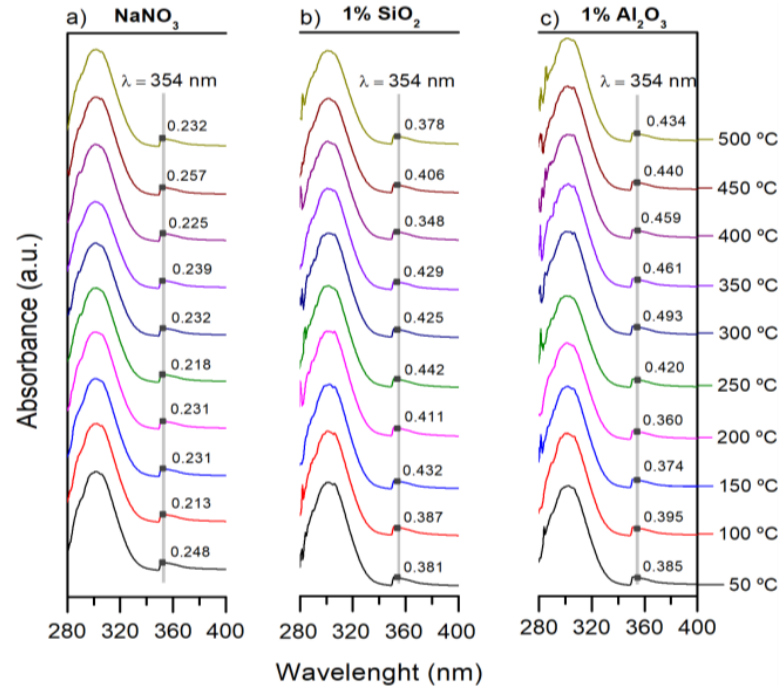
NaNO /Al O NF (1% wt.) derived from the absorbance (arbitrary units) at 354 nm as a function of 3 2 3